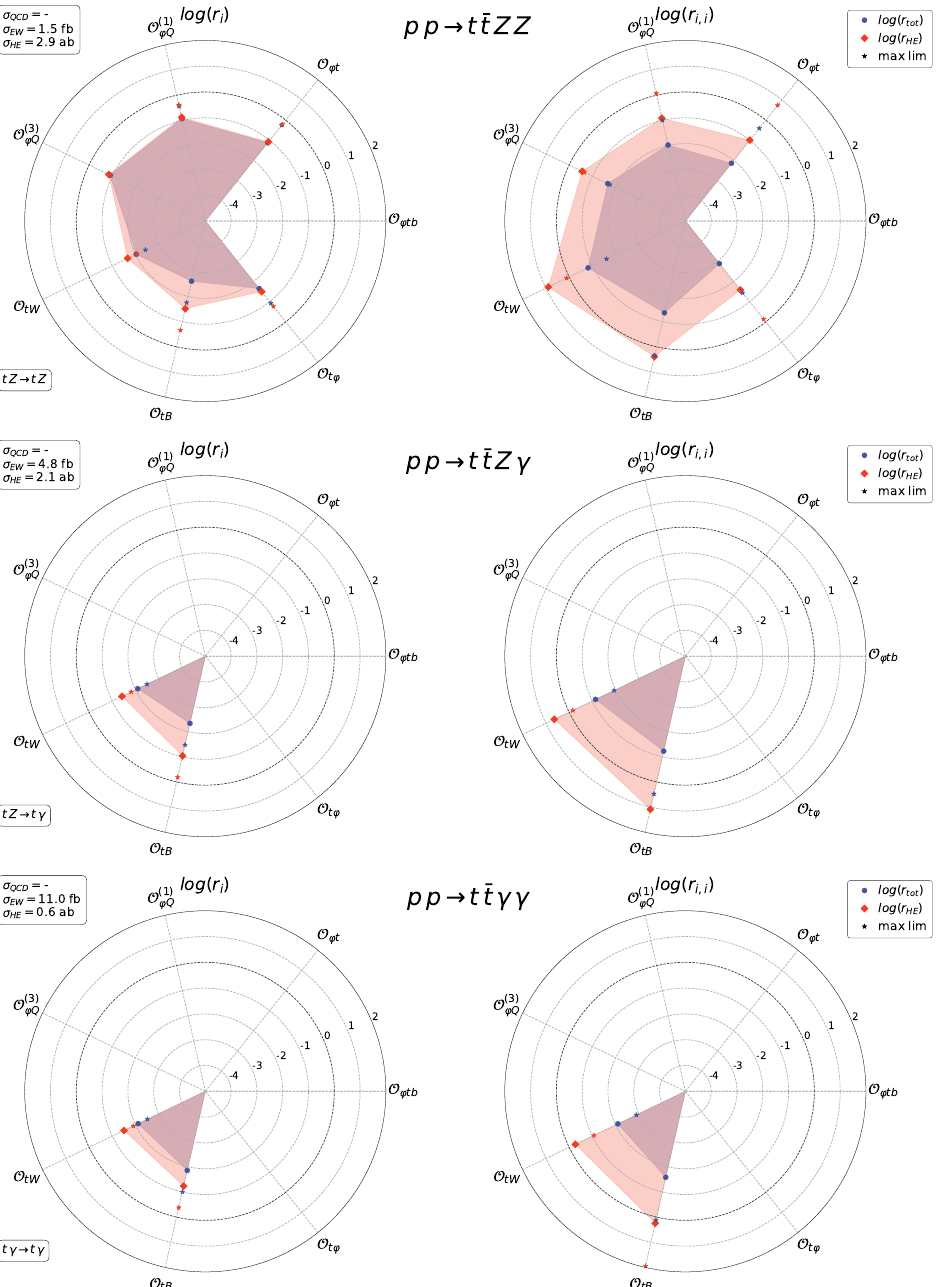
Figure 29. Radar plot for the p p LHC, see (cid:12)gure 7 and section 4.1.2 of the main text for a detailed description.